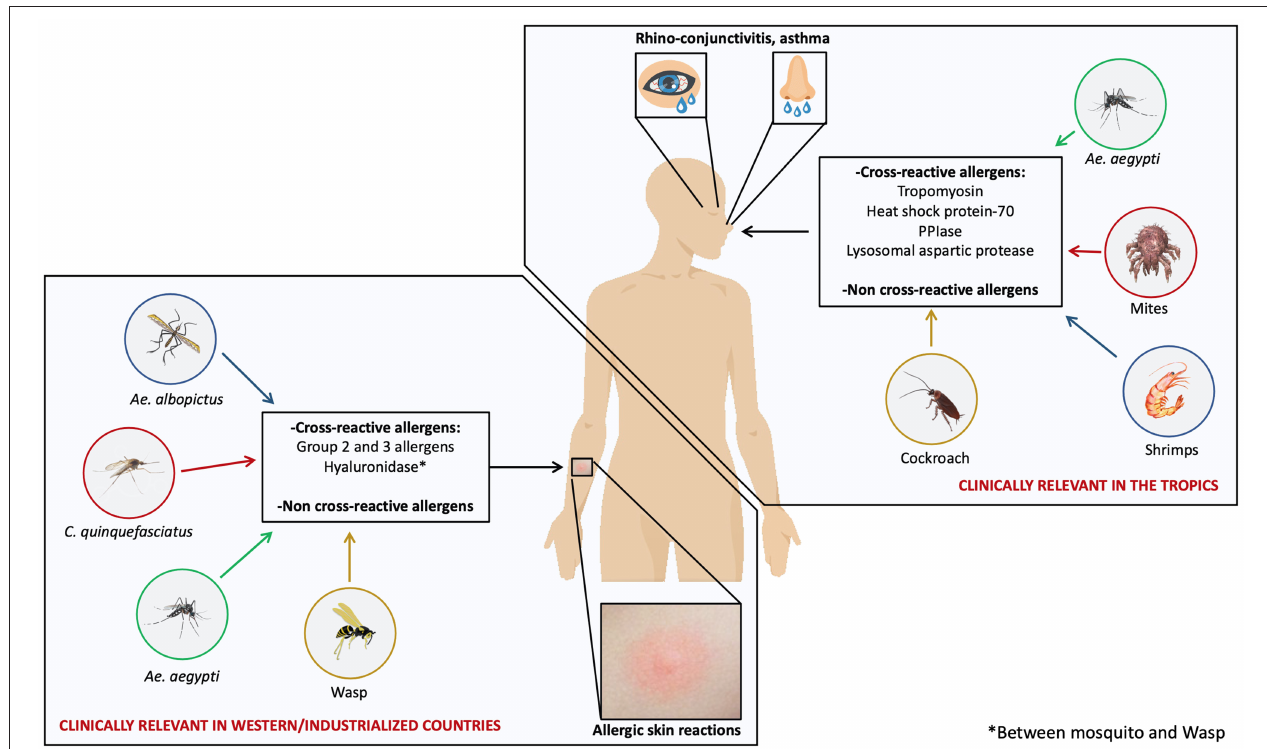
FIGURE 1 | Unique and cross-reactive mosquito allergens induce different manifestations of mosquito allergy. Mosquito species such as Ae. aegypti , Ae. albopictus , and C. quinquefasciatus are distributed worldwide; however, some studies suggest that two kinds of allergic reactions induced by mosquito allergens are clinically relevant depending on the geospatial location: allergic skin reactions induced by salivary allergens and respiratory reactions induced by body-derived allergens. Skin reactions are common in western and industrialized countries and respiratory reactions are relevant in tropical areas. Cross-reactivity between mosquito species and with several species within Arthropods may play an important clinical